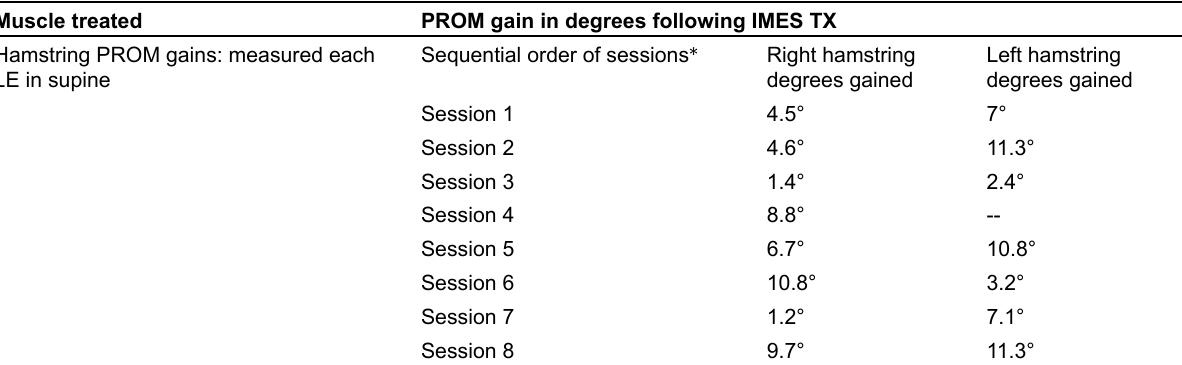
Table 2. Trend of PROM gain in degrees following IMES TX Muscle